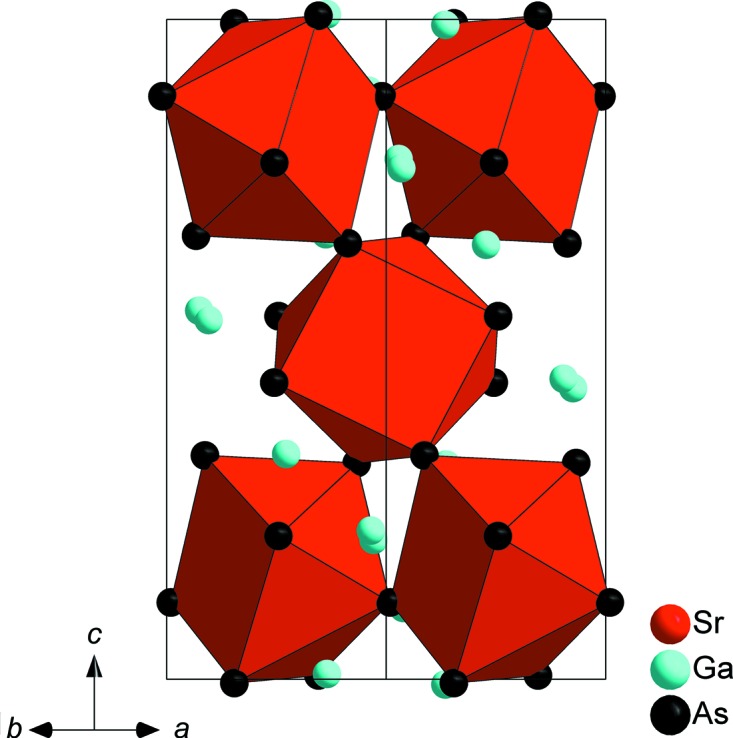
The unit cell of SrGa4As4, viewed along [
0], with the quadratic anti­prismatic strontium coordination spheres shown as red polyhedra.